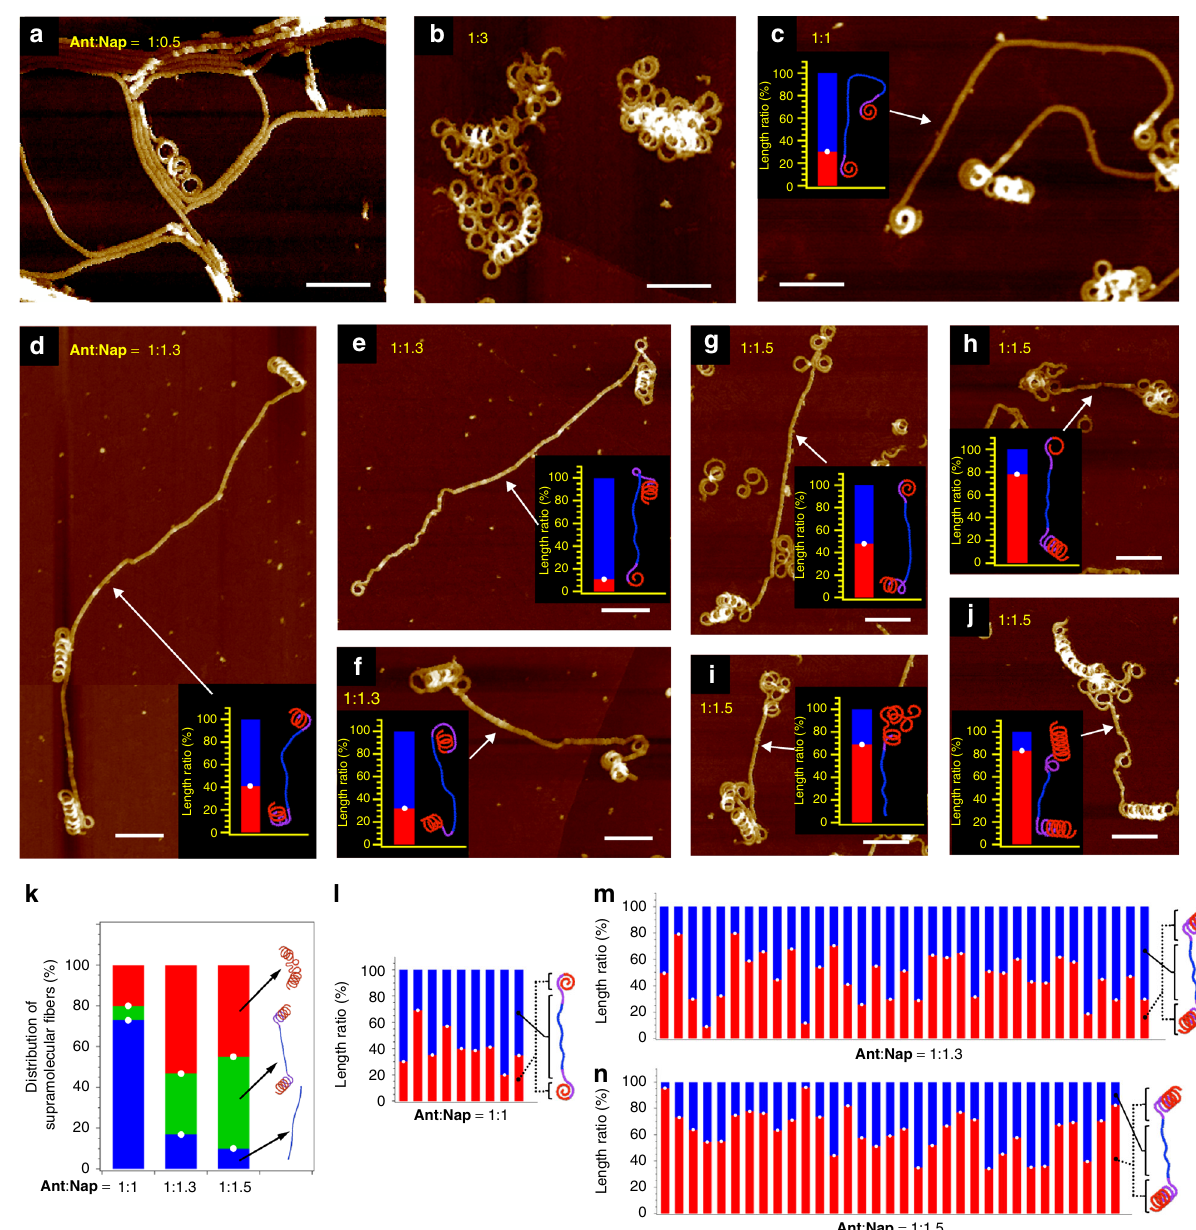
Fig. 5 Structural analysis of the supramolecular copolymers. a – j AFM images of supramolecular copolymers prepared by cooling hot MCH solutions of 1:0.5 ( a ), 1:3 ( b ), 1:1 ( c ), 1:1.3 ( d – f ), and 1:1.5 ( g – j ) mixtures of Ant and Nap from 373 to 293 K using a cooling rate of 1.0 K min − 1 . The concentration of Ant in all the mixtures remained constant (1.0 × 10 − 5 M), whereas that of Nap varied according to the mixing ratio (scale bars, 100 nm) Inset bar graphs show the length ratio of the linear (blue) and coiled segments (red). k Distribution of supramolecular fi bers with helical (red), chimera (green) and linear (blue) topologies for the 1:1, 1:1.3, and 1:1.5 mixtures of Ant and Nap from the analysis of 14, 22, and 12 AFM images, respectively. The total number of fi bers